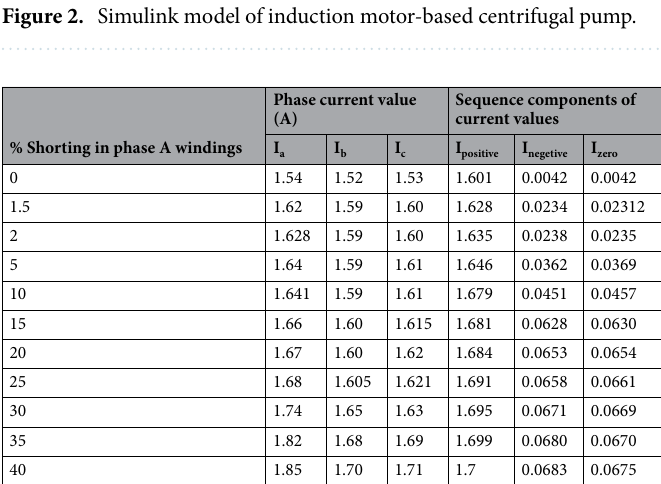
Table 1. Magnitude of phase current and sequence component current in different % shortings of Phase A winding.